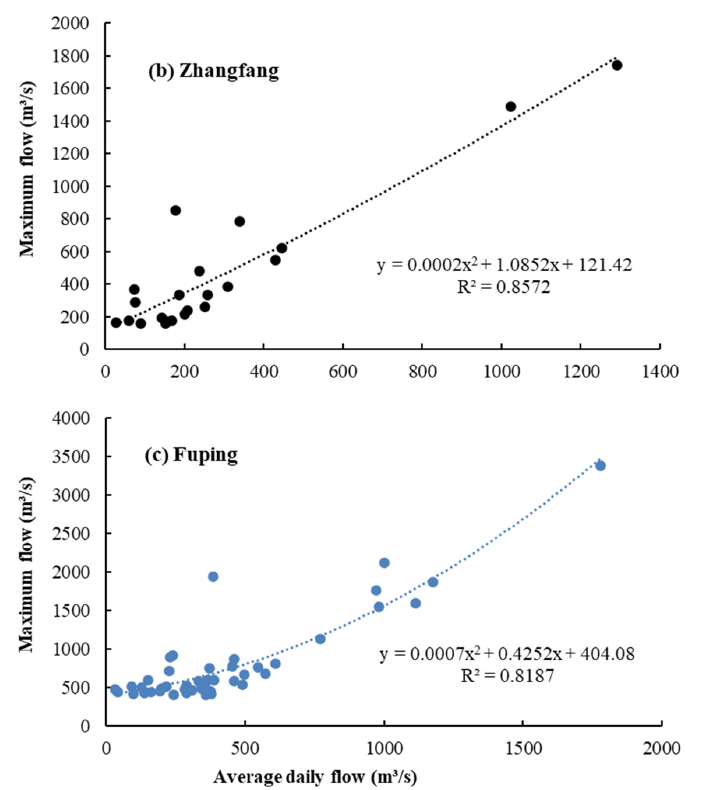
Figure 6. Relationship between daily average flow and maximum flow.